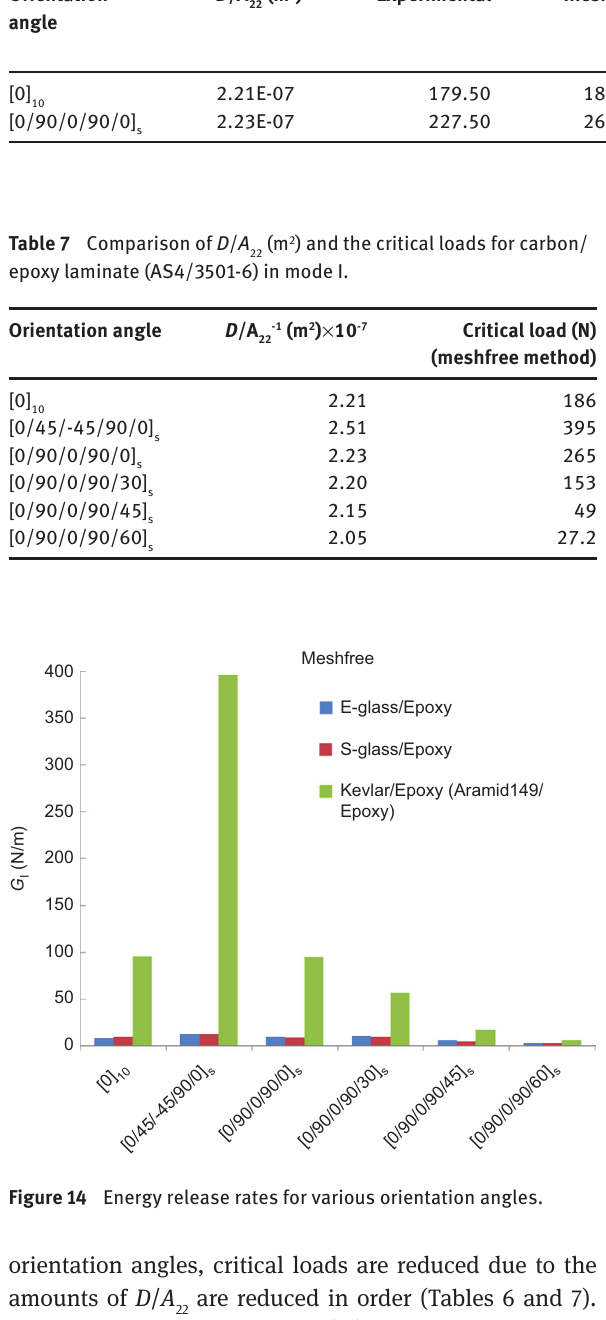
Table 6 Comparison of the critical loads for carbon/epoxy laminate (AS4/3501-6) in mode I. Orientation angle